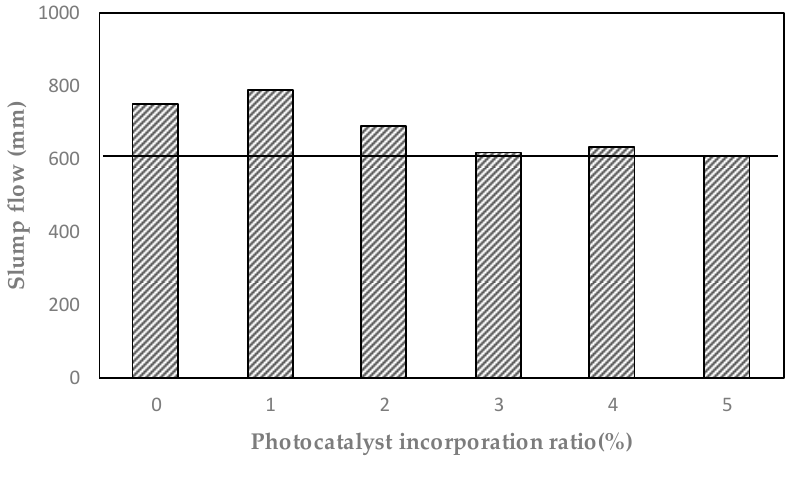
Figure 6. Slump flow test results.